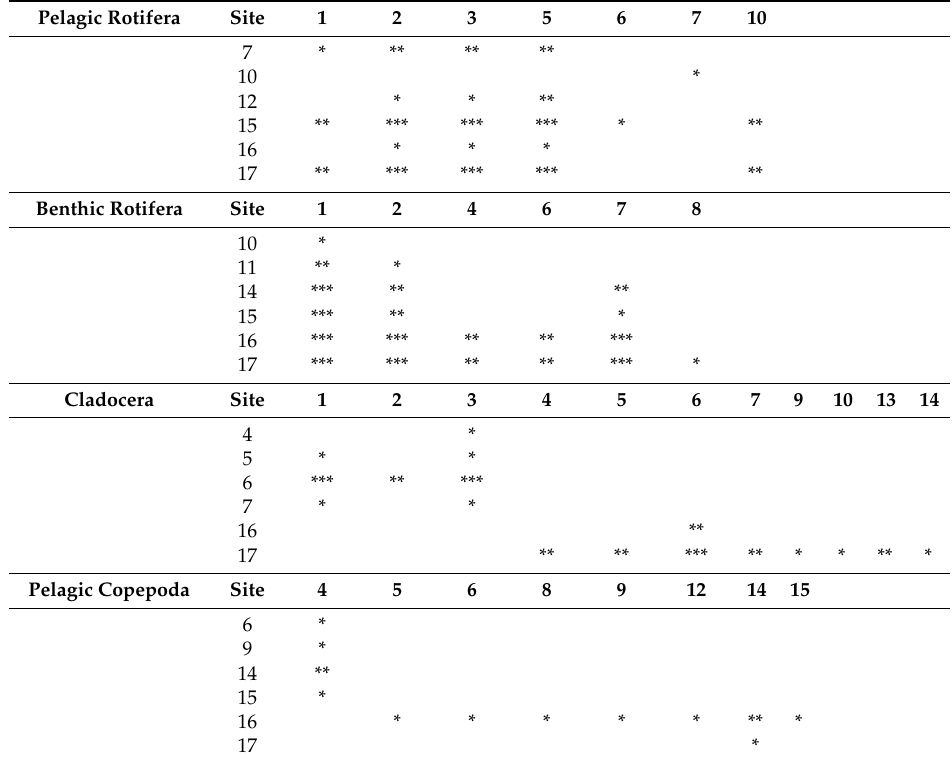
Table 5. Significant differences ( p –values) in zooplankton abundance between the examined